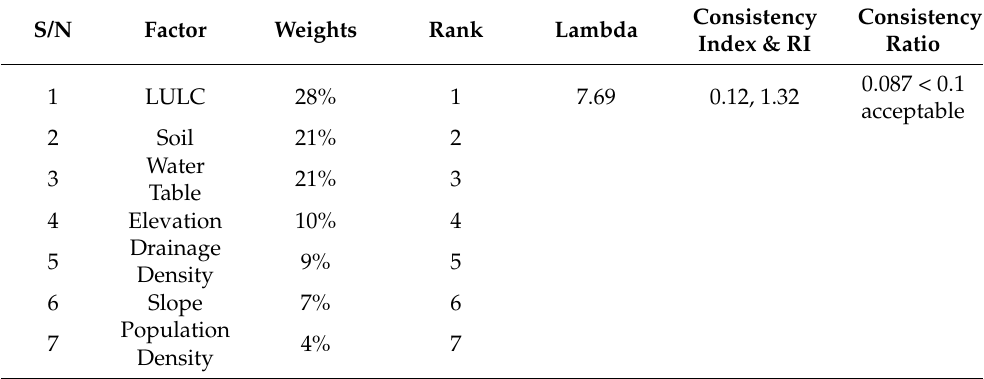
Table 7. Final weights and consistency measurement of factors using